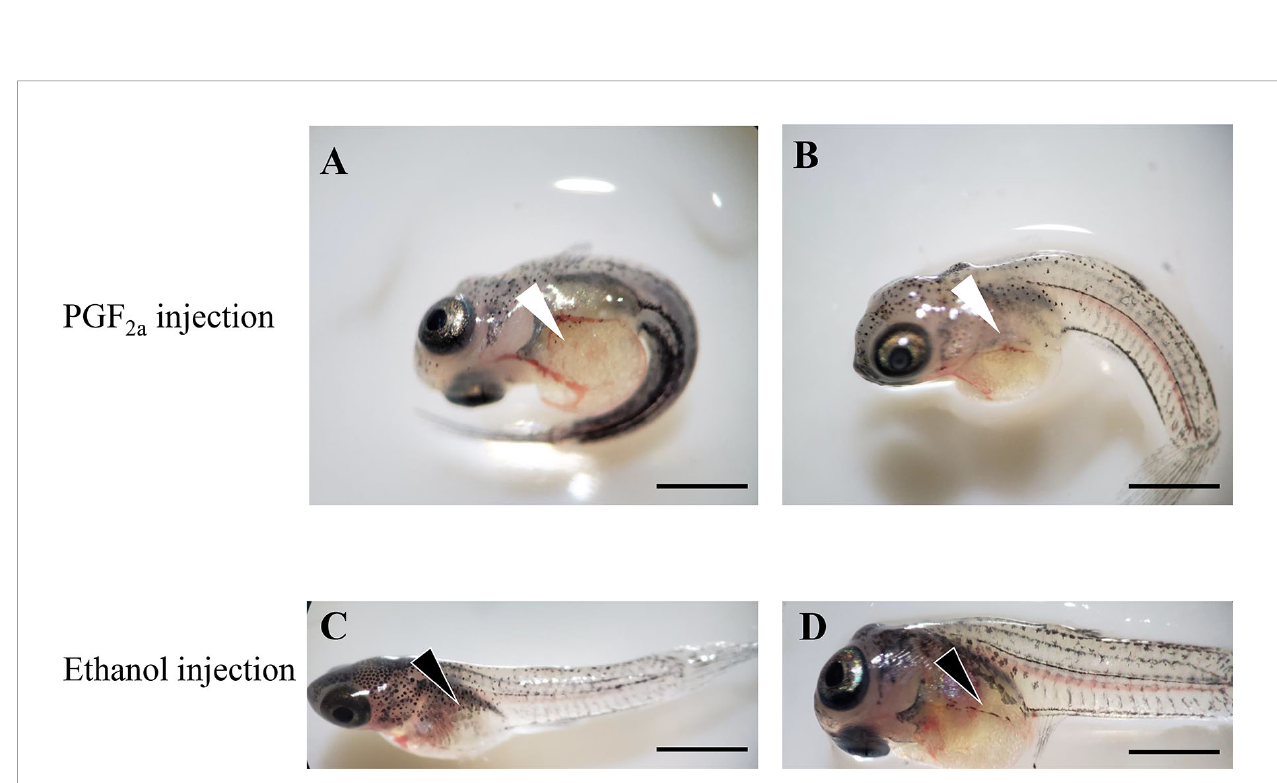
FIGURE 10 | Offspring of pregnant guppies injected with PGF 2a (1,000 ng/g) or ethanol (vehicle control). The PGF 2a injection induced premature parturition, and larval fi sh presented larger yolk sac (white arrowheads) and curly bodies (A, B) . n=5. Normal larval fi sh from ethanol-injected pregnant guppies presented a regular yolk sac (black arrowheads) and stretched bodies (C, D) . n=5. Scale bar, 1